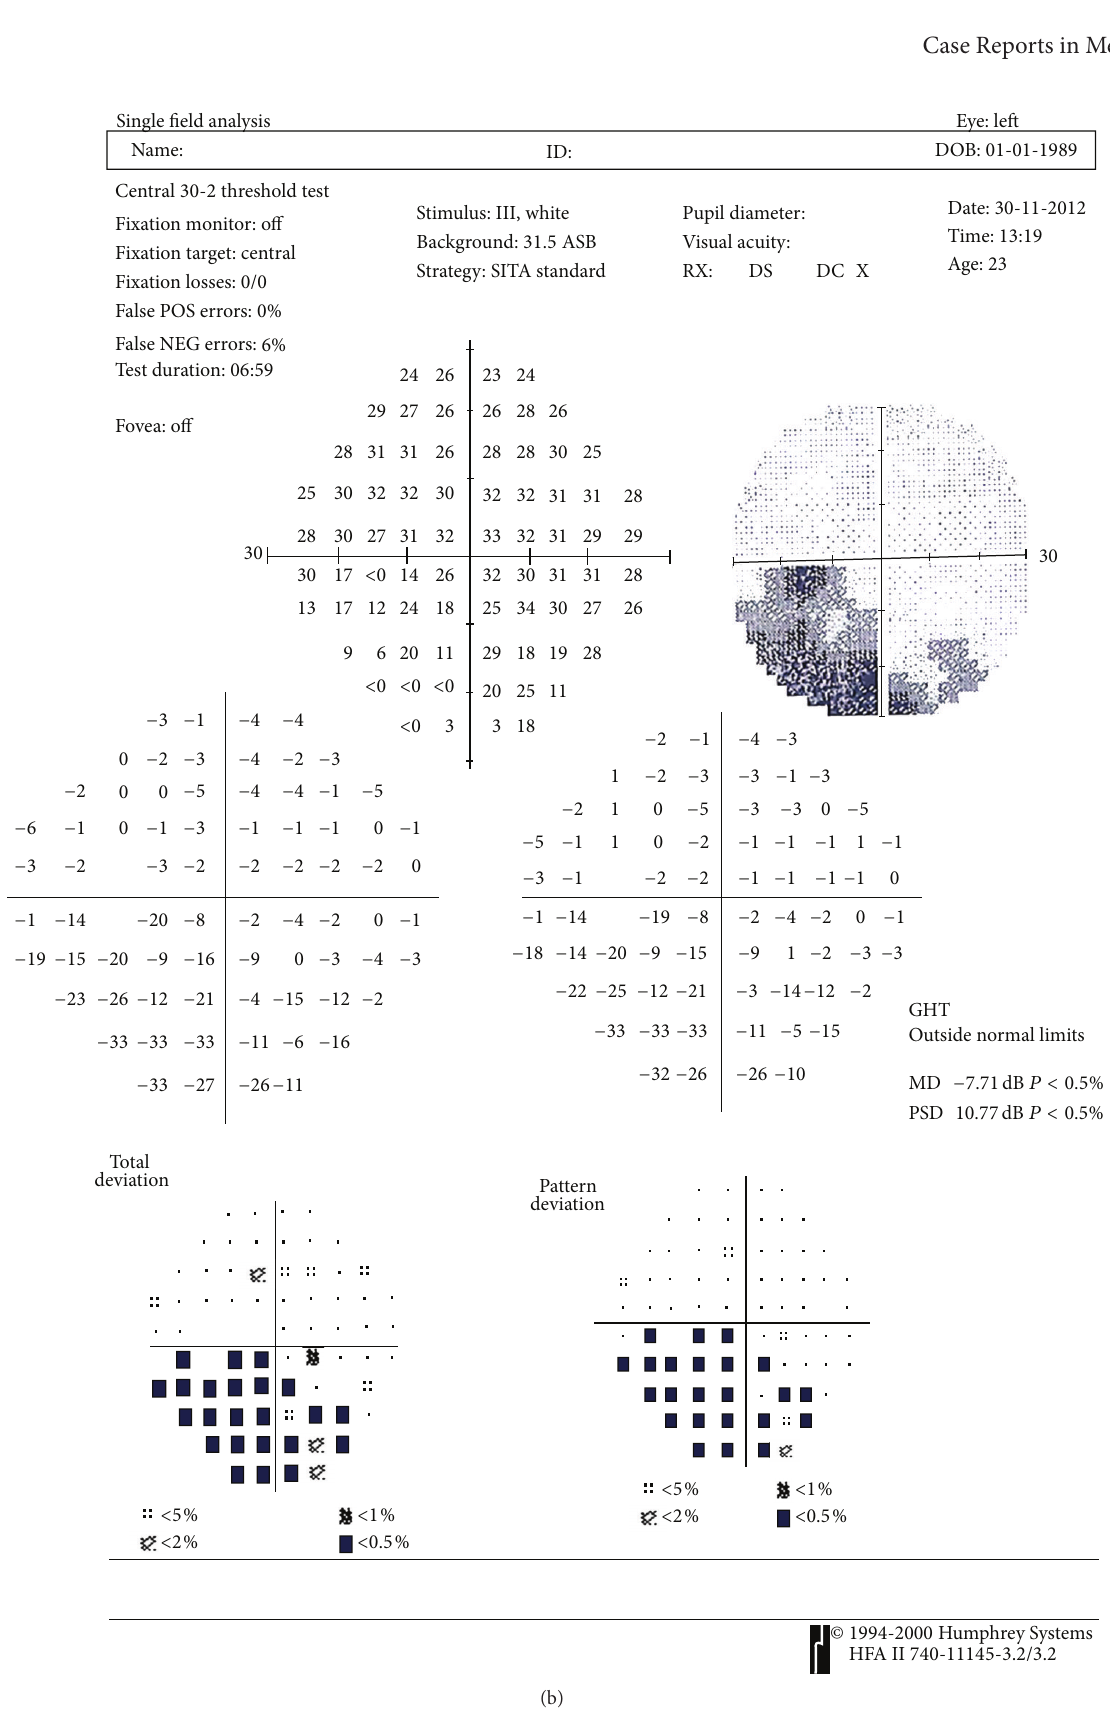
Figure 5: Visual field of right eye (a) and left eye (b) demonstrating deterioration of the right eye and involvement of the